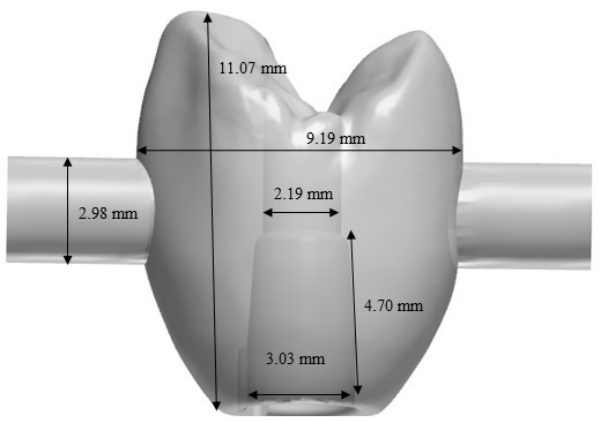
Figure 2. Dimensions of the zirconia abutment coping fabricated by computer-aided design/computer-aided manufacturing